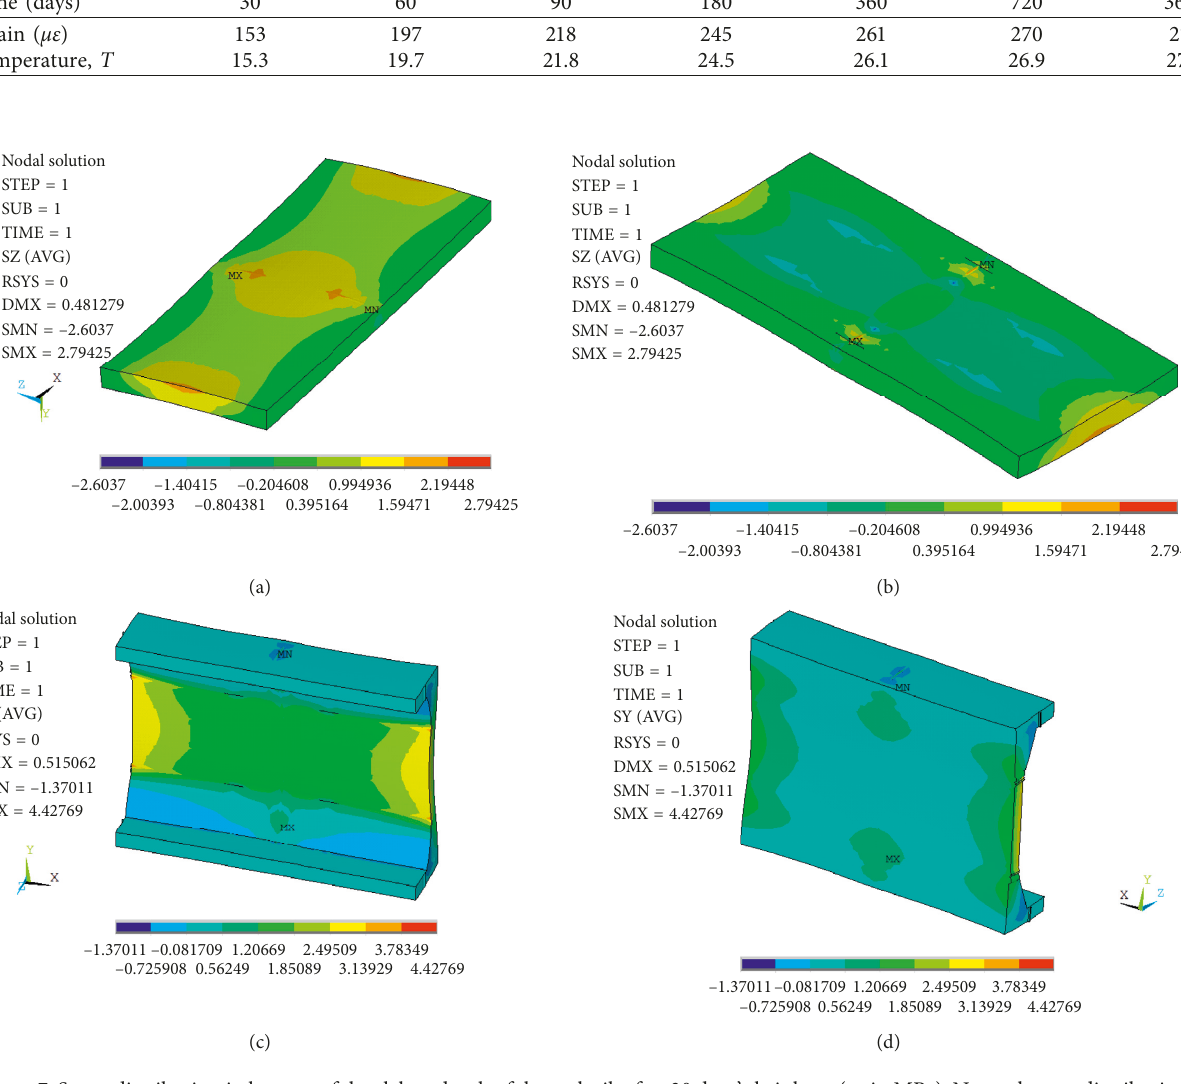
Figure 7: Stress distribution in bottom of the slab and web of the arch rib after 30 days’ shrinkage (unit: MPa). Normal stress distribution in Z -direction on (a) the inner surface of the bottom slab and (b) the outer surface of the bottom slab. Normal stress distribution in the Y - direction on (c) the inner surface of the web and (d) the outer surface of the web.